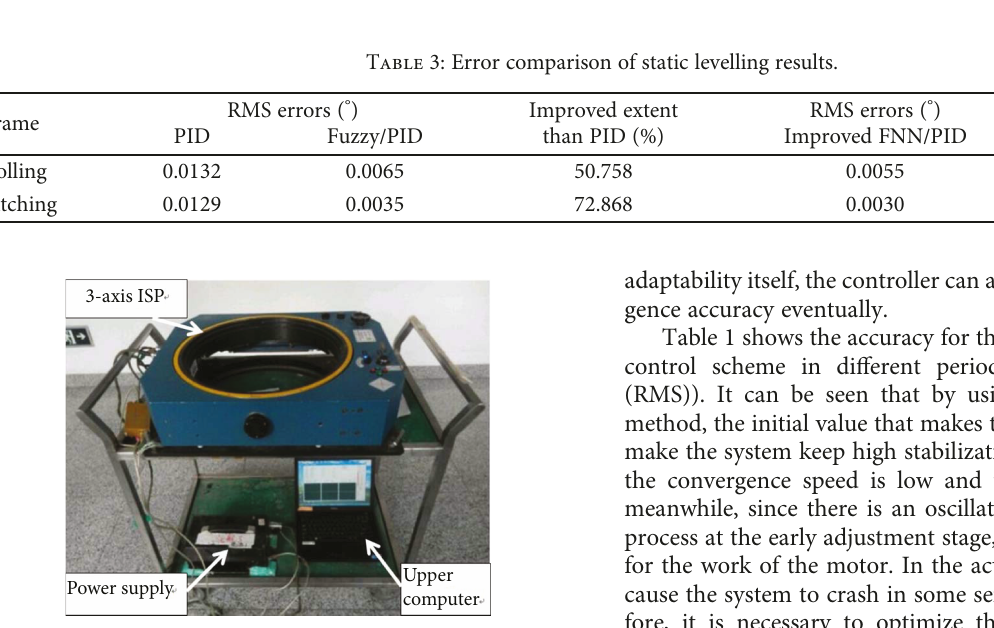
Figure 18: The picture of the three-axis ISP in moving base